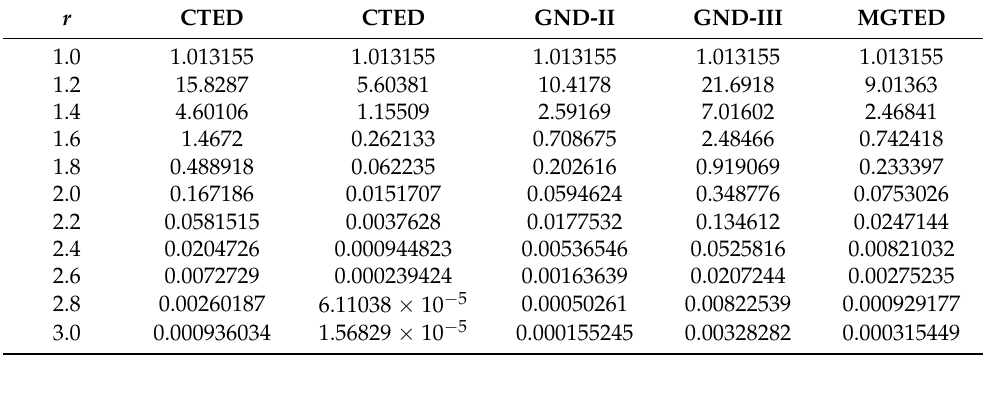
Figure 5. The chemical potential 𝑃 for different thermo-diffusion models.